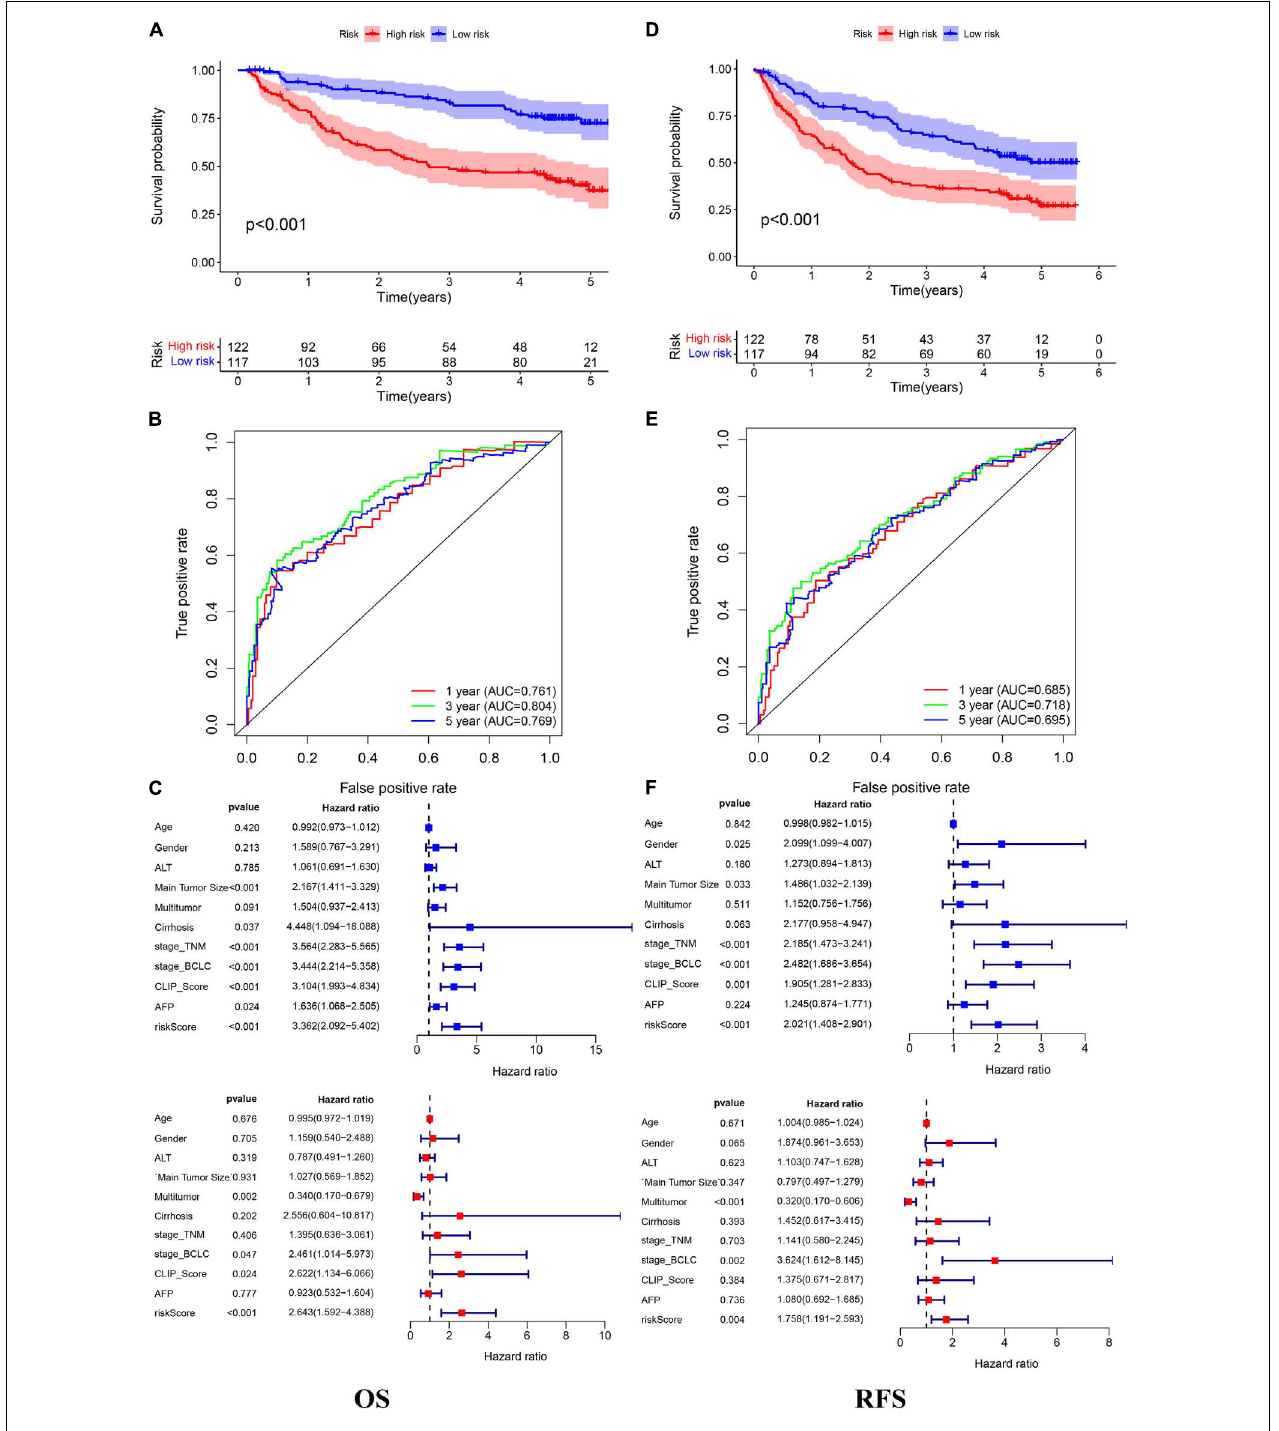
FIGURE 5 | The Kaplan–Meier survival analysis, the time-dependent ROC analysis, and the Cox analysis of the risk score in the GSE14520 cohort (A–C) OS and (D–F) RFS. *For (C,F) blue represent univariate Cox analysis, red represent multivariate Cox analysis.